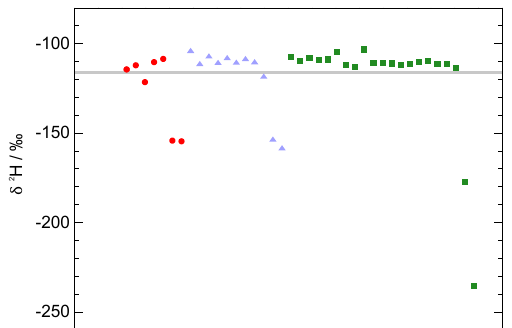
Figure 4. In order to estimate the required minimum mass of the substances to yield stable isotope ratios, the isotope ratios are plot- ted against the peak area (here using the example of n -octane). Mean value and 3 σ interval calculated by using values with stable isotope ratios (here above 8nAs) are represented as black solid line and grey shaded area, respectively. The pre-concentrated mass of n -octane is colour coded. For n -octane the minimum required mass is estimated to 310ng corresponding to about 50ng hydrogen.